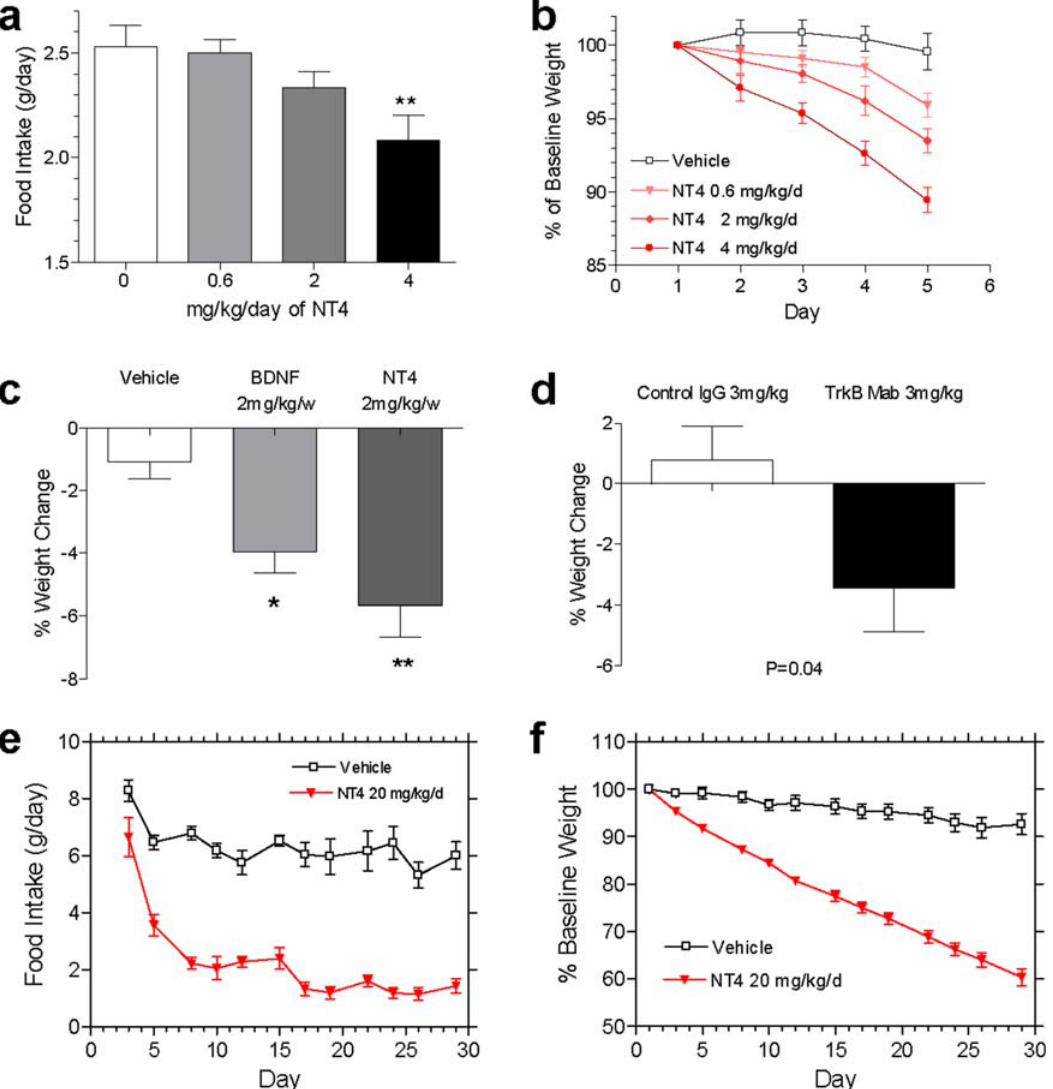
Figure 1. Treatment with TrkB agonists reduces food intake and weight in mice. a, Daily IV injection of 0.6, 2 or 4 mg/kg of NT4 (n=6 per group) resulted in dose dependent reduction in average daily food intake over 5 days in adult male DIO mice (One way ANOVA, P=0.0098, F=4.967 with Dunnett’s posttest, P , 0.01 for 4 mg/kg group compared to the vehicle group, while no statistically significant effects were observed at 0.6 or 2 mg/kg). b , Daily IV injection of 0.6, 2 or 4 mg/kg of NT4 (n=6 per group) resulted in dose dependent reduction in body weight in adult male DIO mice (Two way ANOVA, P , 0.0001 with Bonferroni’s posttests, data are presented as % change relative to baseline body weight). c, Weekly IV injection of 2 mg/kg BDNF (n=7) or NT4 (n=7) led to significant weight loss compared to the vehicle treatment (n=8) in adult male DIO mice at 10 days after the first dose (One way ANOVA, P=0.002, F=9.08 with Dunnett’s posttest). d , Single IV injection of 3 mg/kg TrkB agonist monoclonal antibody (n=7) significantly reduced body weight relative to control IgG treatment (n=7) in adult male DIO mice 10 days after dosing (Student’s t test, 2 tailed, P=0.04). e–f , Daily treatment of Leptin receptor-deficient, 12 week old female db/db mice for 30 days with IV-delivered 20 mg/kg of NT4 (n=7) decreased daily food intake by 50–80% ( e ), and body weight by 40% ( f ) relative to the vehicle treated mice